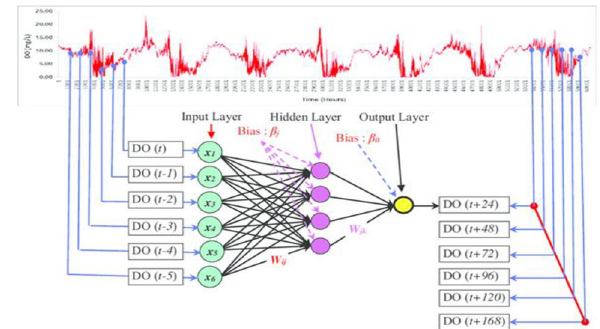
Fig. 10 Artificial neurons (schematic)